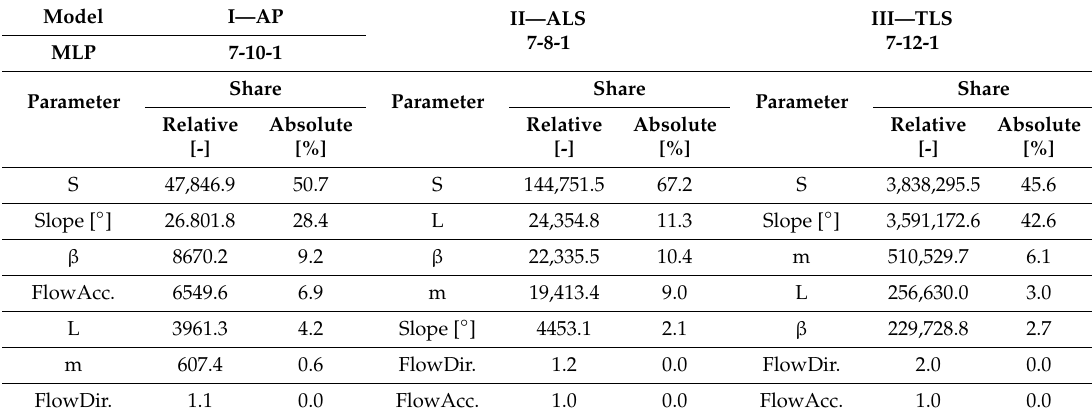
Table 5. Absolute and Relative Percentage Shares in Explaining the LS